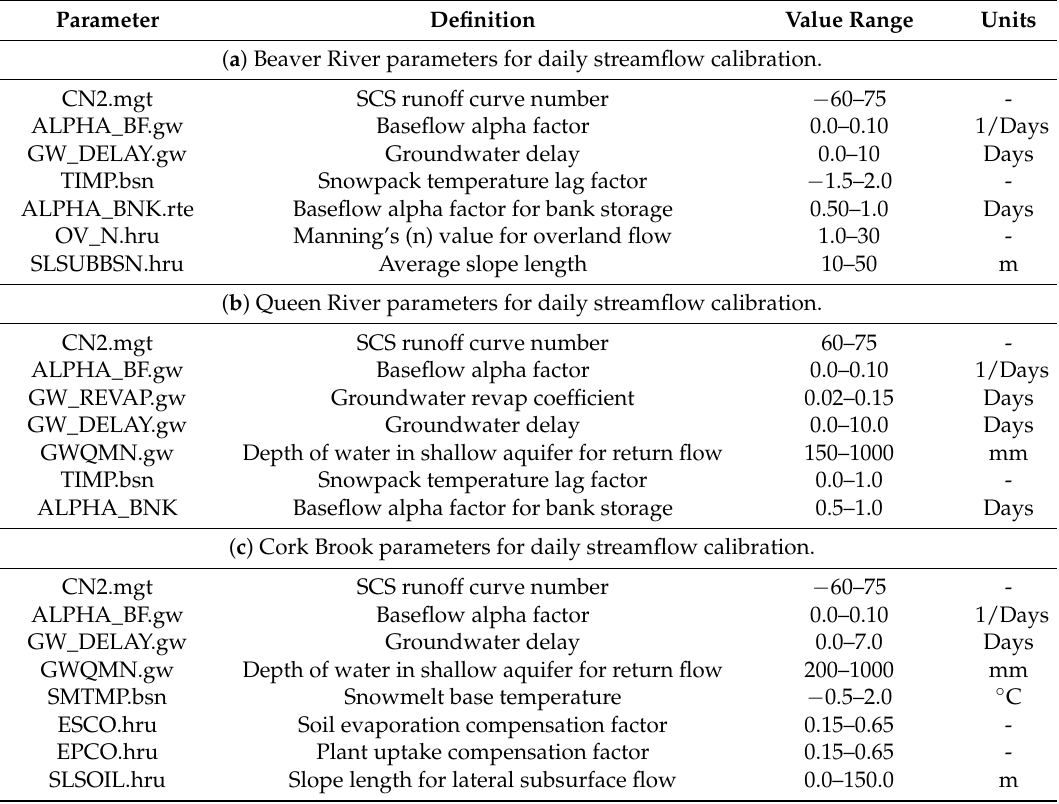
Table 3. Range of values for ten most sensitive parameters during daily streamflow calibration using SWAT-CUP for ( a ) Beaver River, ( b ) Queen River and ( c ) Cork Brook. Parameters are listed by name and SWAT input file type, definition and the range of values that were selected for the